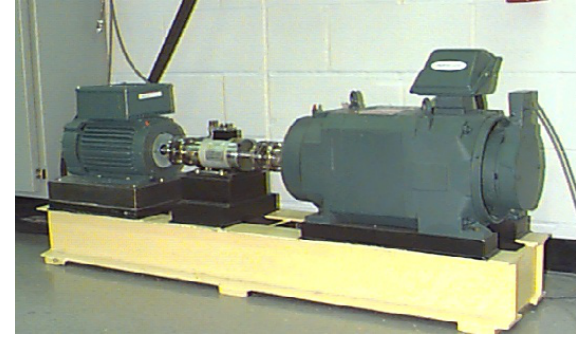
Fig. 13. Motor system in bearings inner raceway fault detection [23].